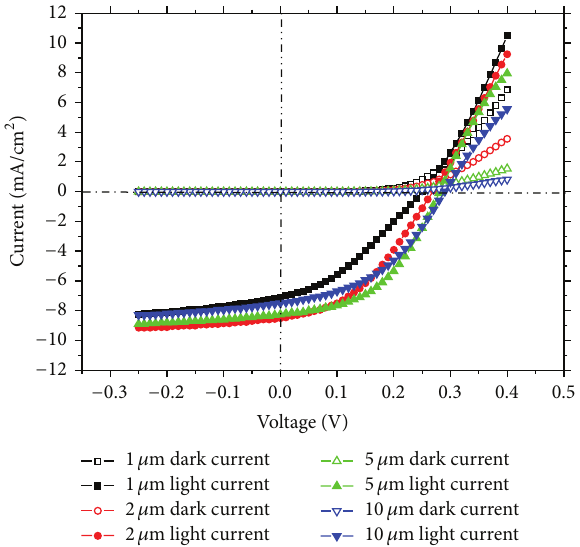
Figure 4: Current-voltage curves of graphene solar cells versus dif- ferent GaAs thickness.